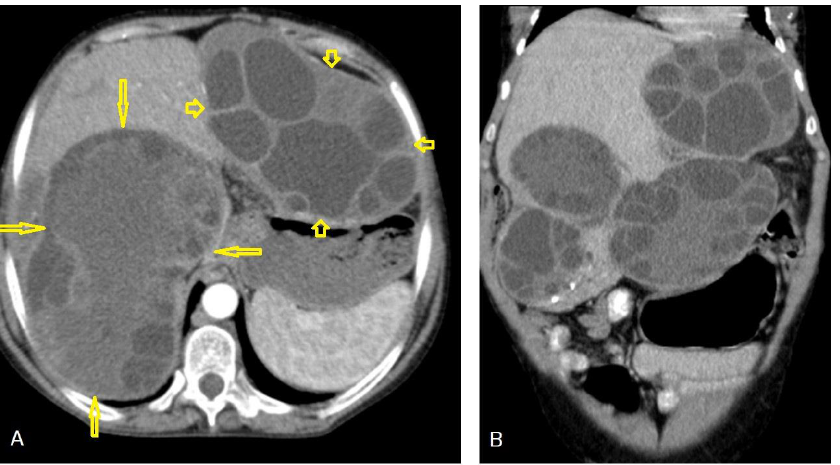
Figure 8. Selected axial ( A ) and coronal ( B ) CT images of a 60-year-old female showing multiple well-defined cystic lesions occupying the liver: about five lesions in the right lobe, where the largest one measured 17 × 9.2 × 15.3 cm (long arrows), occupying the right posterior lobe, and two cysts occupying the left lobe, where the largest one measured 11.4 × 10.3 × 8.7 cm (short arrows). Most of the lesions contain multiple vesicular cysts inside them (daughter cysts). The lesions exert a compression effect on the portal vein, stomach, and ascending colon, intending to reach the right kidney upper pole. This is a typical picture of an active-stage hydatid cyst Type IIA.